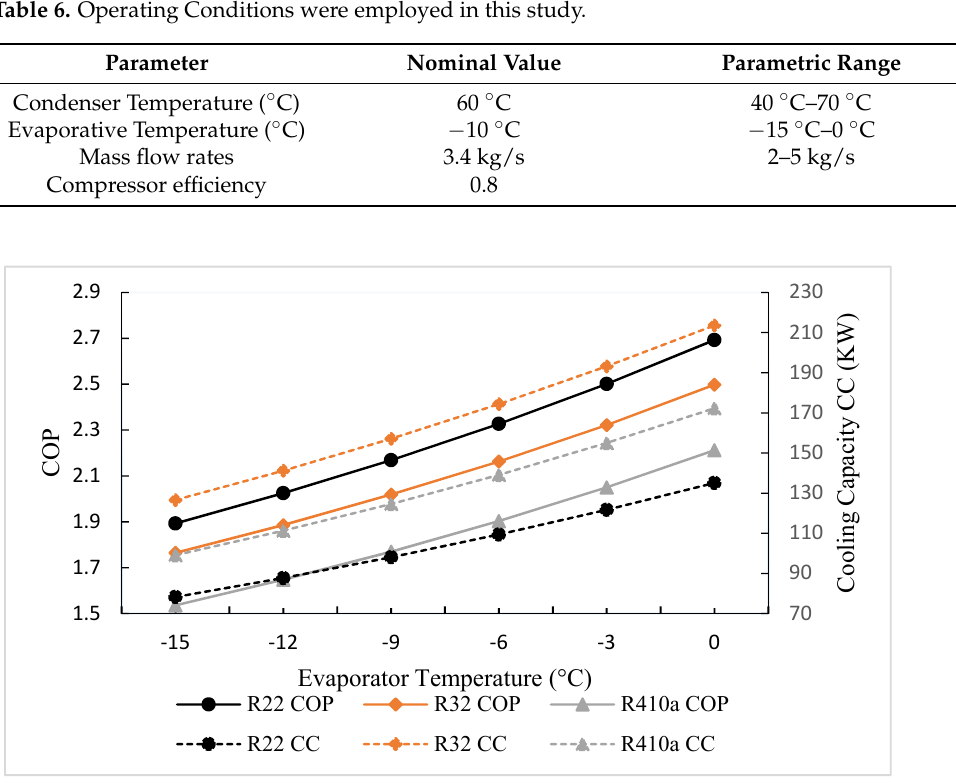
Figure 6. The effect of refrigerant mass flow rate on the evaporative temperature at constant con-